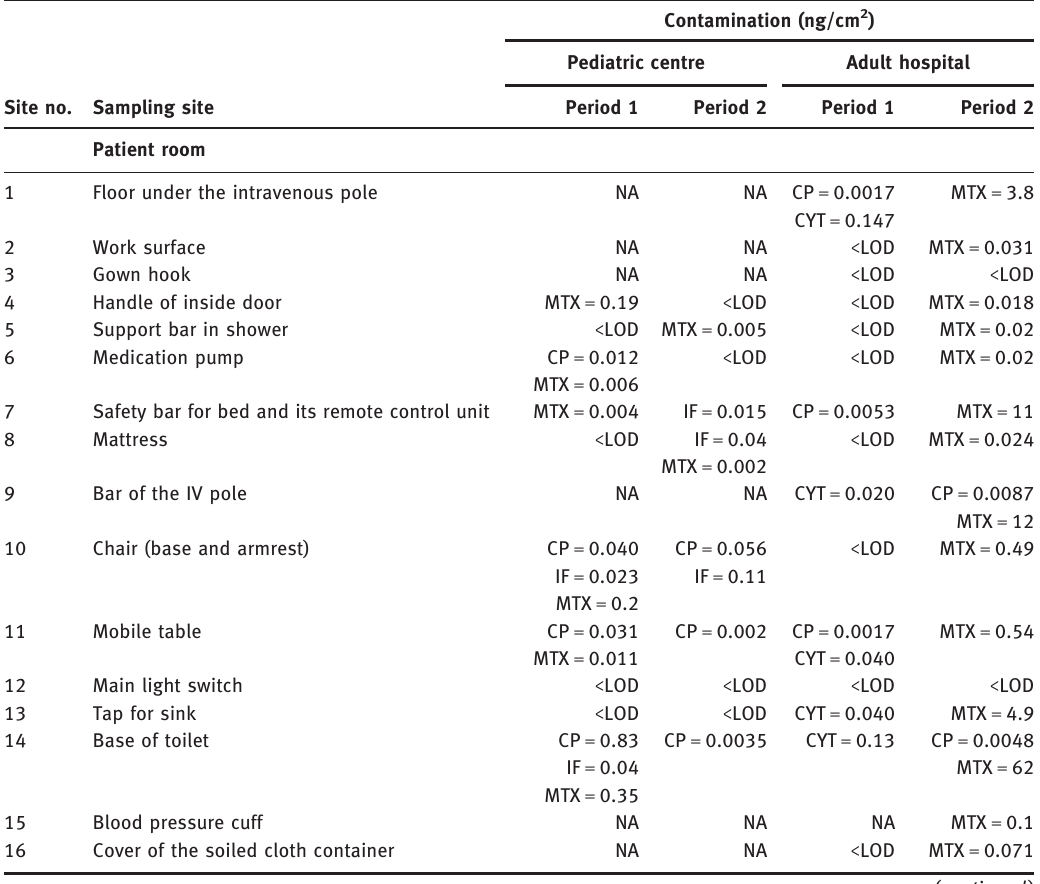
Table 2: Results of surface sampling in inpatient